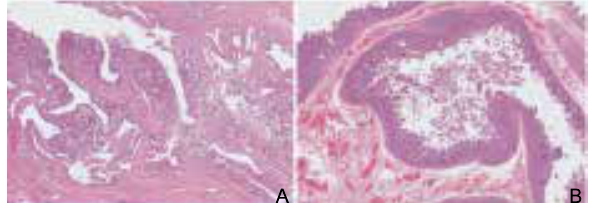
Figure 5 Microscopic features of the tubular adenoma (Hematoxylineosin stain) showed tumor consisted of small heterogeneous tubular ducts with fibrous tissues (A, × 100). There was no cell atypia or mitotic activity (B, ×